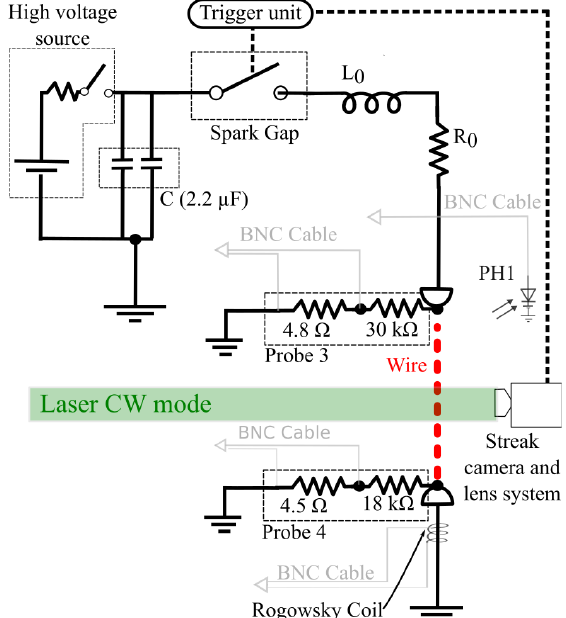
Figure 1. (Color online) Experimental setup. “Probe 3” and “Probe 4” are voltage dividers, PH1 signals the photodiode, C the capacitors bank, and L 0 and R 0 the lumped inductance and resistance of the electrical circuit,